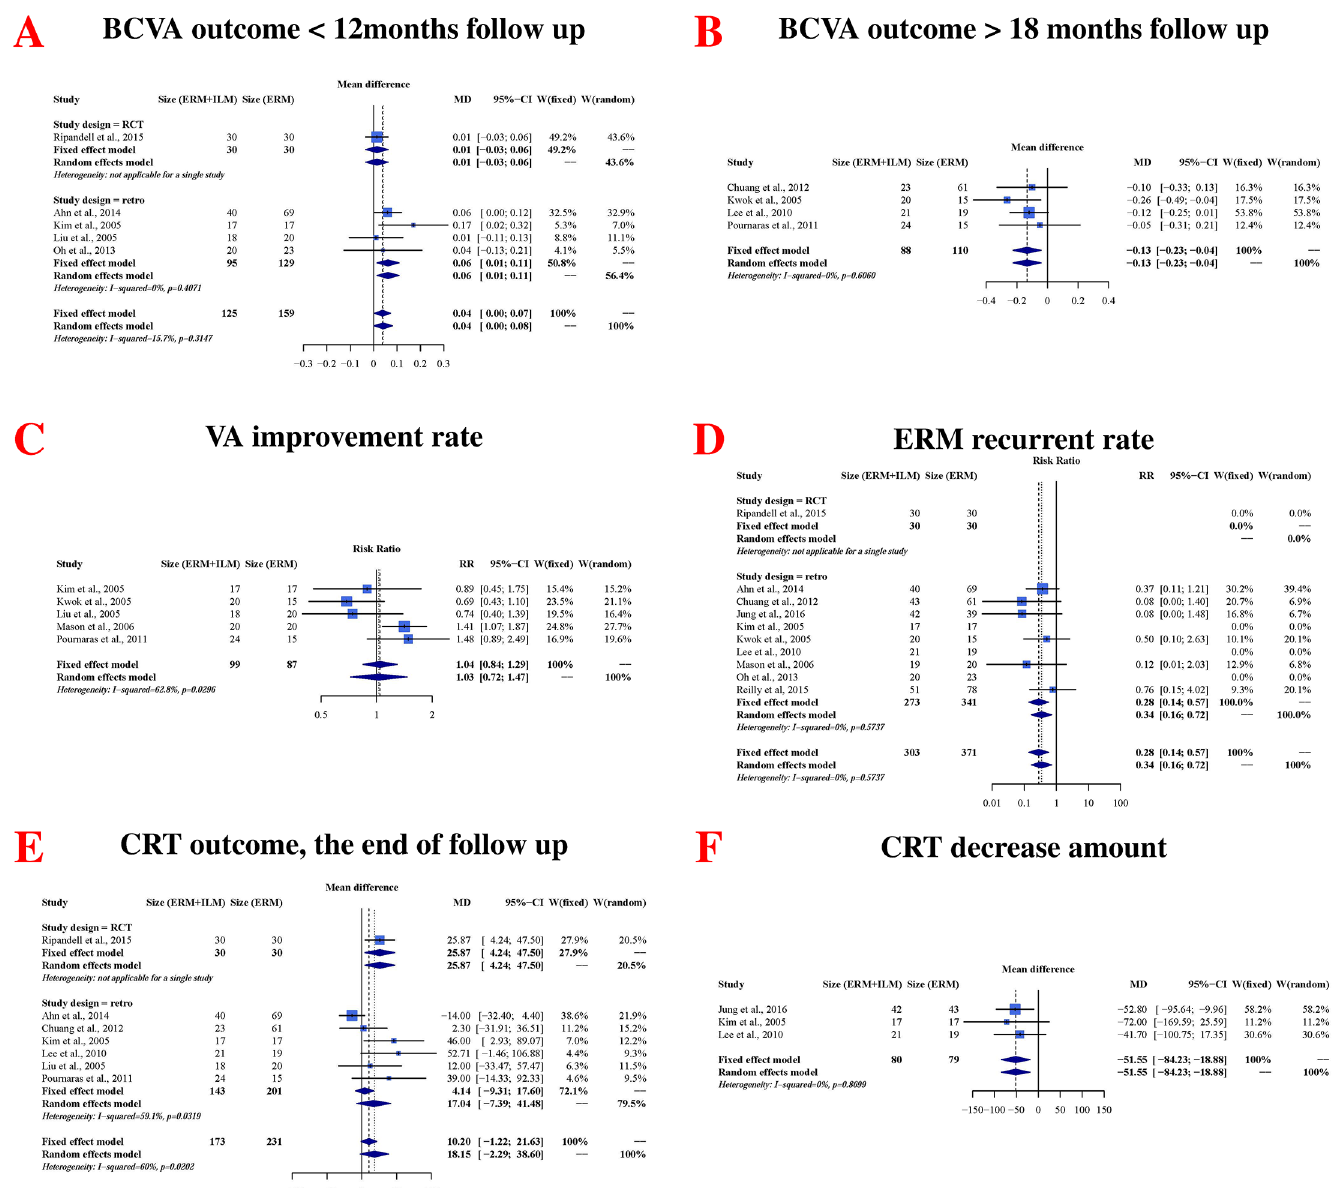
Fig 2. Main results from the meta-analysis of vitrectomy with epiretinal membrane (ERM) and ILM peeling or with only ERM peeling in idiopathic ERM. (A) Best-corrected visual acuity (BCVA) < 12 months follow-updurationafter surgery; vitrectomy with only ERM peelingyielded significantly better results; (B) BCVA > 18 months follow-updurationafter surgery; vitrectomy with ERM+ILM peelingyieldedsignificantly better results; (C) rate of improvement in visual acuity, definedas (cid:21) 2 Snellenlines at the end of follow-up; the difference betweenthe two groups was nonsignificant (D) ERM recurrence rate; was significantly lower in the ERM + ILM peelinggroup than in the ERM peelingonly group (E) central retinal thickness (CRT) at the end of follow-up; the difference betweenthe two groups was nonsignificant; (F) CRT reductionat the end of follow-up;CRT reductionwas significantly higherin the ERM peelinggroup than in the ERM+ ILM